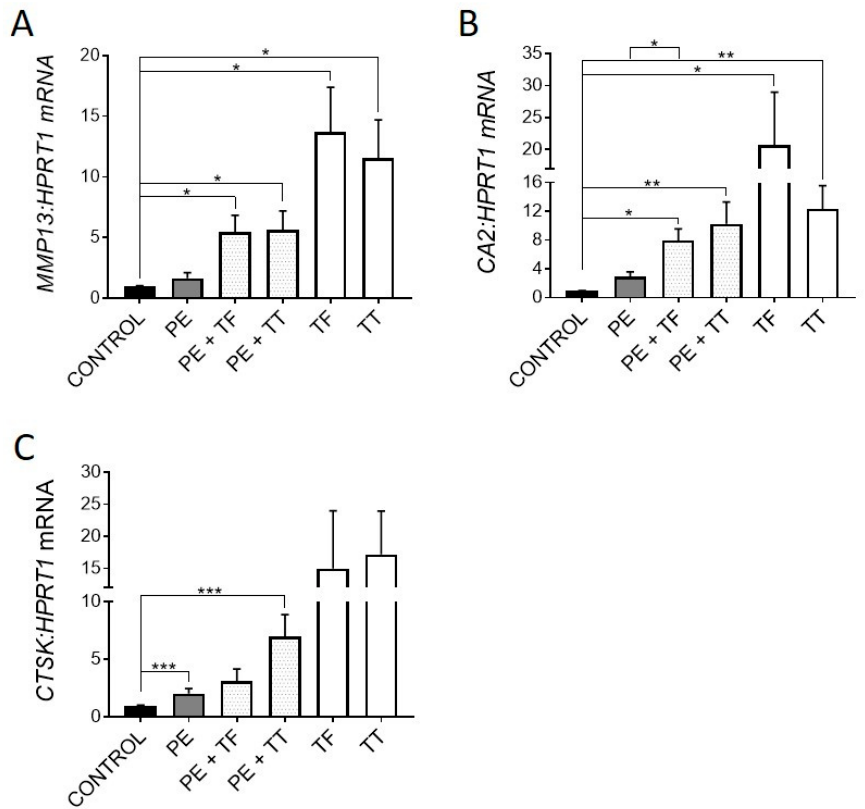
Figure 3. Effect of vitamin E and UHMWPE particles on expression of genes associated with osteocytic osteolysis. ( A ) MMP13 mRNA expression, ( B ) CA2 mRNA expression, ( C ) CTSK mRNA expression. Data shown are means ± standard error of the mean (SEM) of quadruplicate experiments analysed in duplicate. Significant differences are denoted by * p < 0.05, ** p < 0.01, *** p < 0.001.